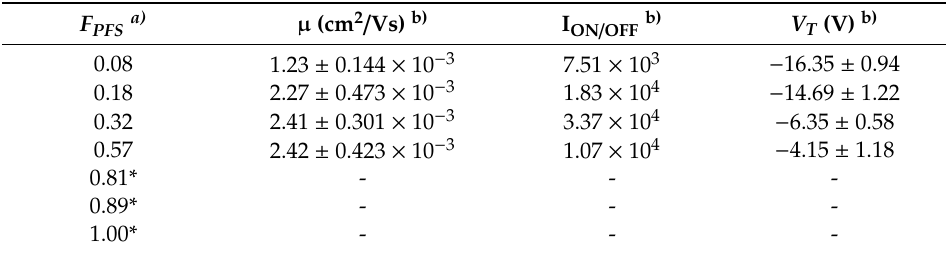
Table 4. Bottom-gate top-contact (BGTC) copper phthalocyanine (CuPc) based OTFTs fabricated using poly(PFS-ran-MMA) copolymers as the dielectric layer.